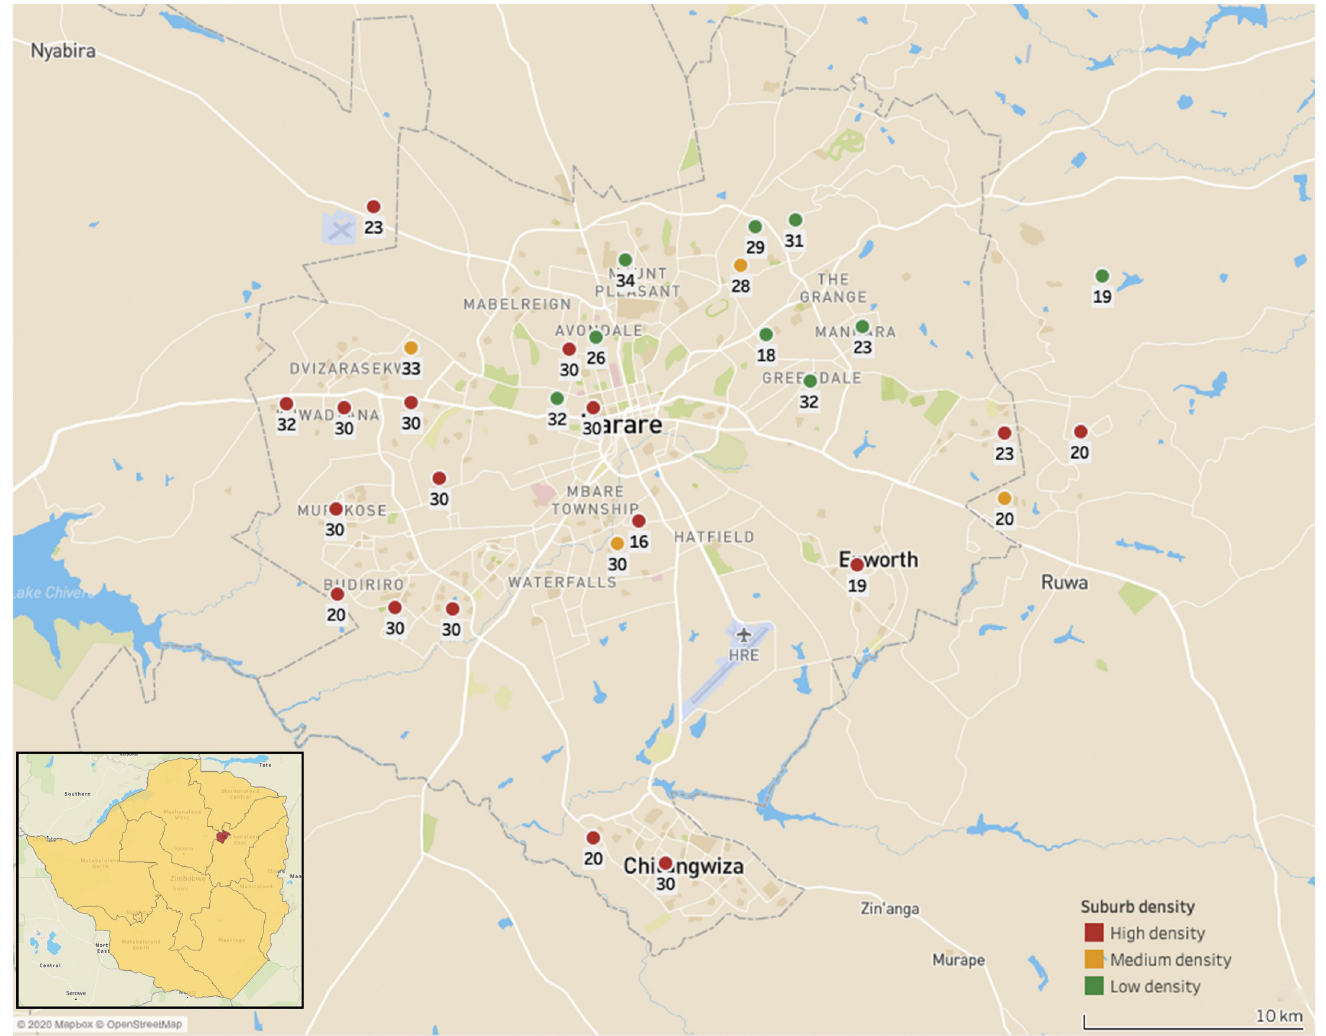
Fig 1. Map of the Harare Metropolitan Province showing locations of sampled suburbs, disaggregated by suburb density. The number associated with each dot represents the number of respondents per suburb. The dots on the maps represent the geographical centre of the suburb and do not represent the size of the suburb in any way. The figures was generated using the Tableau Desktop software package (Version 2020.02) and OpenStreetMap geodata (https://www.openstreetmap. org).